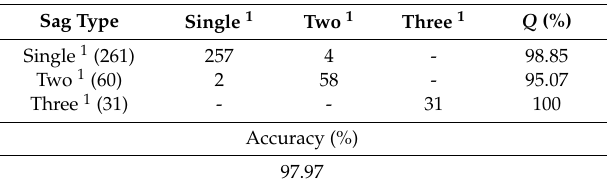
Table 2. Experiment 1 results.